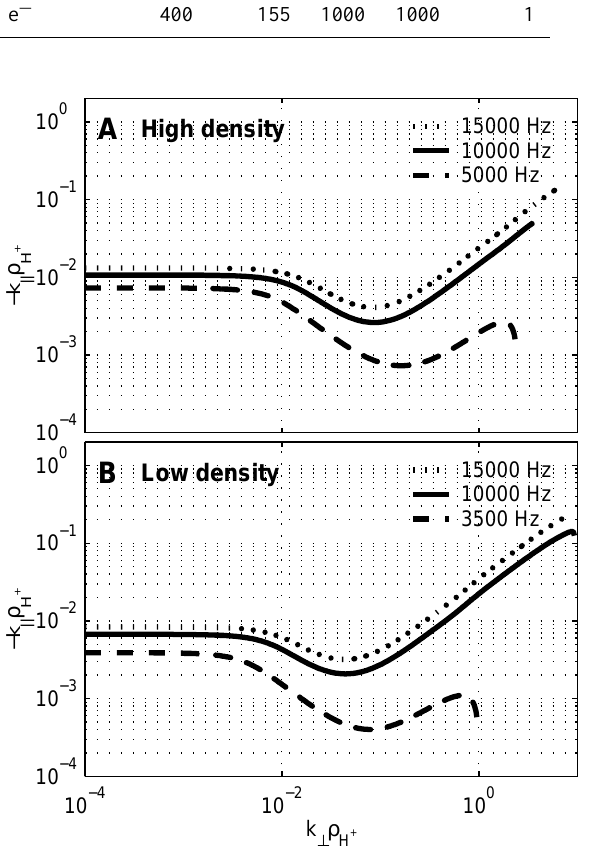
Fig. 9. Constant frequency curves in wave vector space. The parallel and perpendicular wave vectors are normalized to the gyroradius of the 2-eV protons in the models, that is ρ H + =7m. Panel (A) shows the results from modelling the high density case, where irregular density events are present. Panel (B) shows the dispersion curves for the low density case. The overall structure is very similar. We can note a small shift in a curve at a given frequency towards larger k for a higher